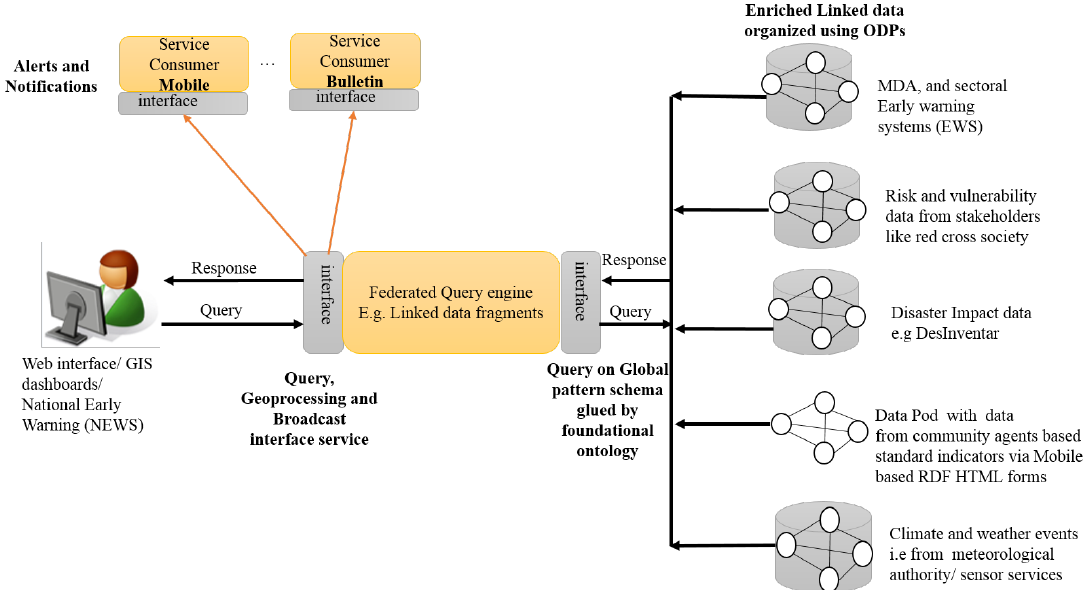
Figure 7. Illustrative example of a modular pattern composition in an early warning